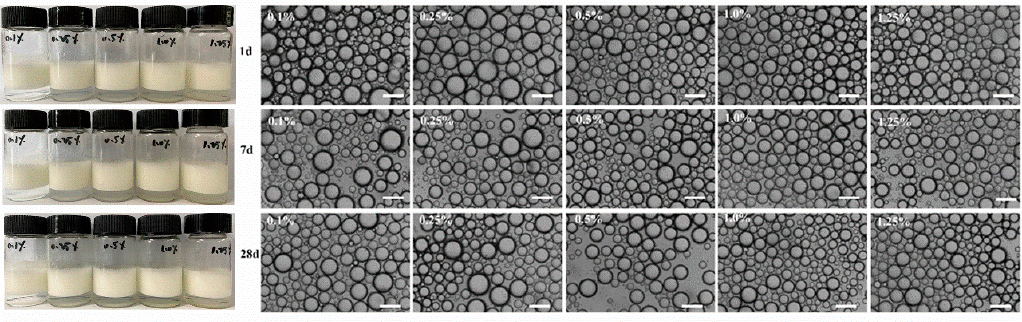
Figure 5. Appearance and corresponding microstructure of WPI fibrils stabilized Pickering emulsions when stored at 1 day, 7 days and 28 days. The scale bar was 100 μ m.